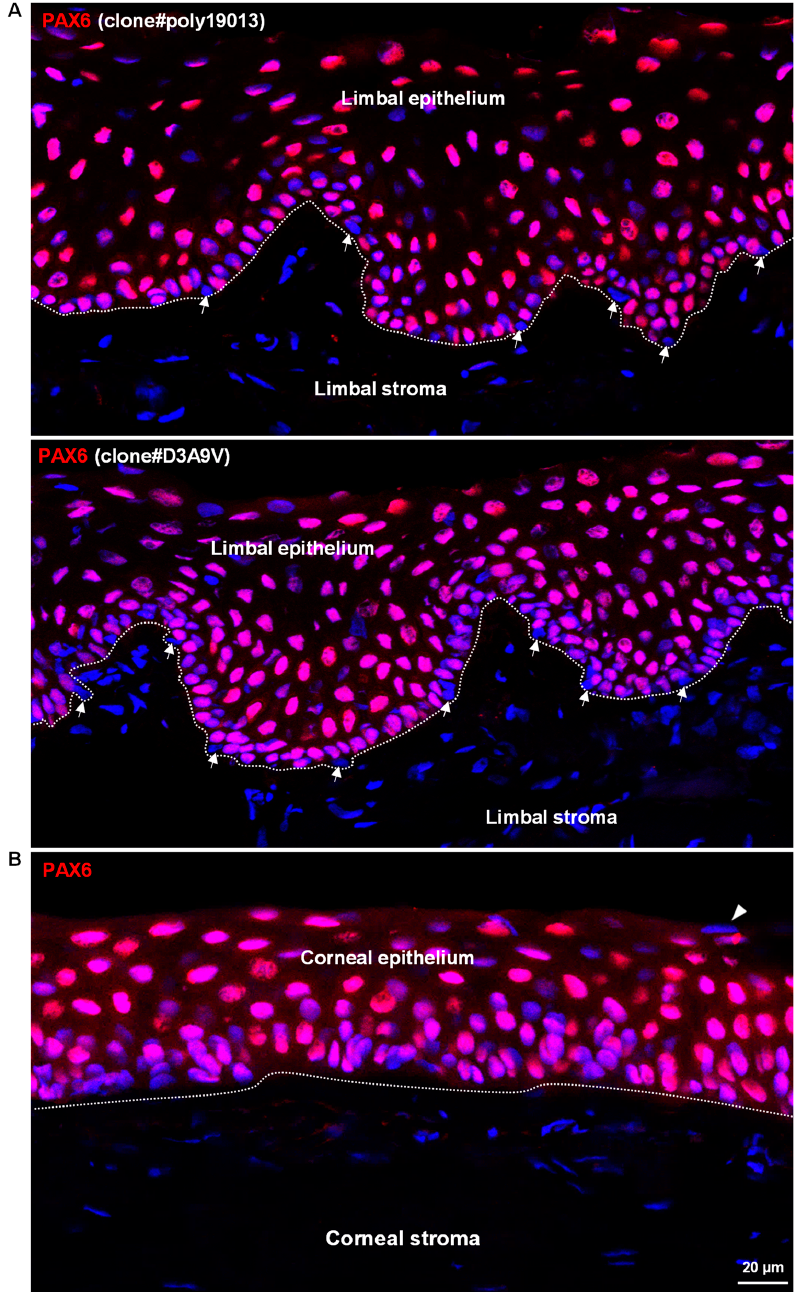
Figure 1. In situ localization of PAX6 ‐ ( A ) Immunostaining of corneoscleral tissue sections showing the nuclear expression of PAX6 (red) in the limbal epithelium as well as PAX6 ‐ negative cells (arrows) in the basal layer of limbal epithelium and in the limbal stroma (dashed line represents basement membrane (BM)). Nuclear counterstaining with 4 ′ ,6 ‐ diamidino ‐ 2 ‐ phenylindole (DAPI, blue). ( B ) Immunostaining of the corneal tissue sections showing the PAX6 expression (red) in all epithelial cells of the cornea (except very few cells in the superficial layers, arrowhead) but not in the stroma (dashed line represents the basement membrane (BM)). Nuclear counterstaining with DAPI (blue).